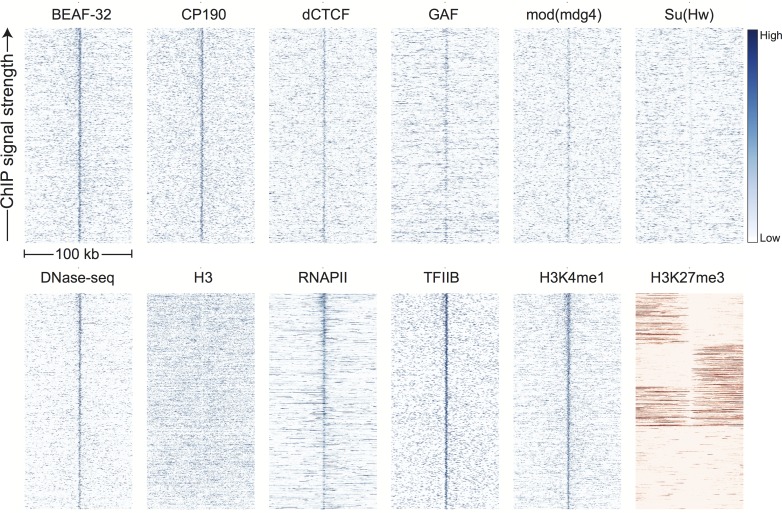
Genomic signals around H3K4me3 peaks.Data were prepared and displayed identically to Figure 3 for the top 1000 peaks of H3K4me3 in stage 5 5 embryos, as identified by (Li et al., 2014). H3K4me3 is a proxy for active promoters.